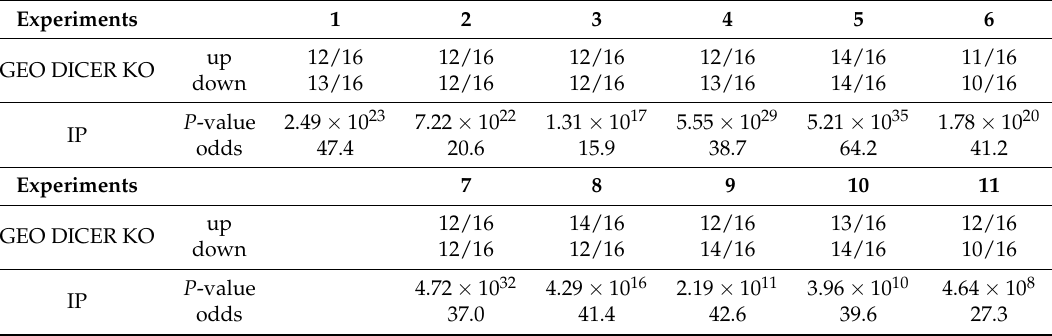
Table 12. GEO DICER KO: The number of experiments among the 16 experiments included in Enrichr whose set of listed genes significantly overlapped with the set of genes identified in each of the 11 experiments. IP: Fisher’s exact test for the overlap between the set of genes that bind to Dicer in immunoprecipitation (IP) experiments and the set of genes selected in each of the 11